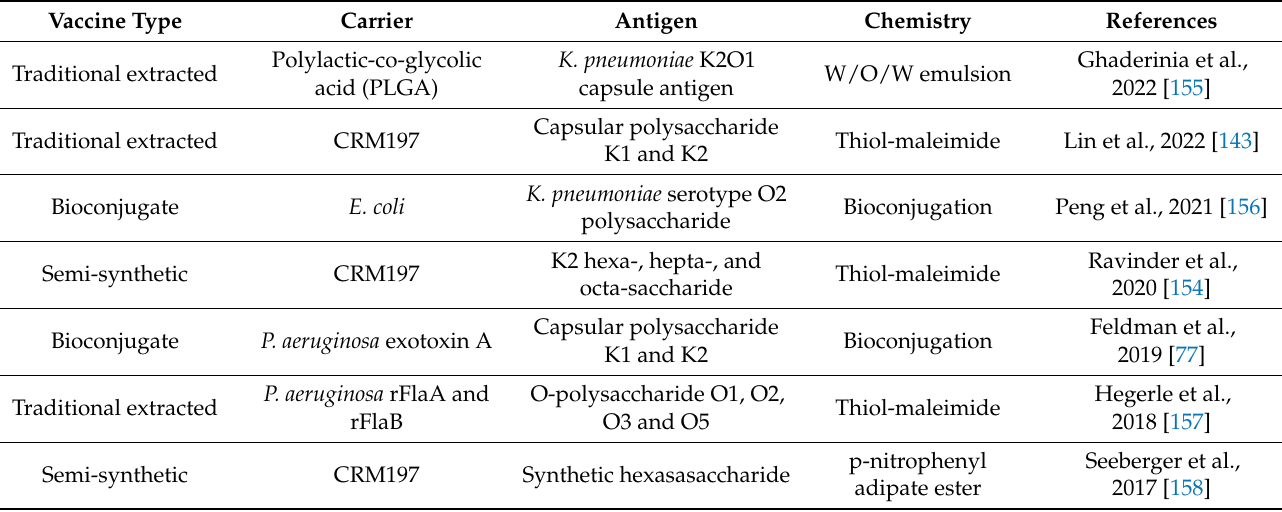
Table 10. Carbohydrate conjugate vaccines targeting Klebsiella pneumoniae .